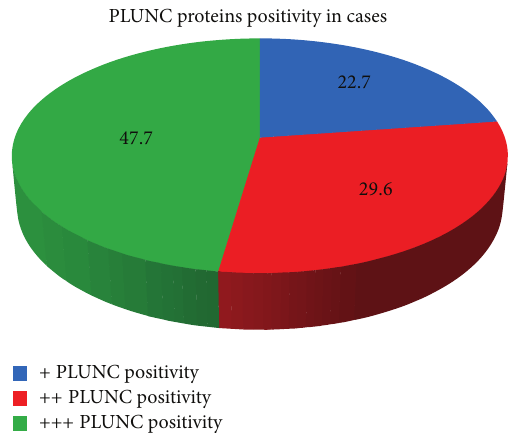
Figure 4: Graphical representation of PLUNC proteins positivity in cases.